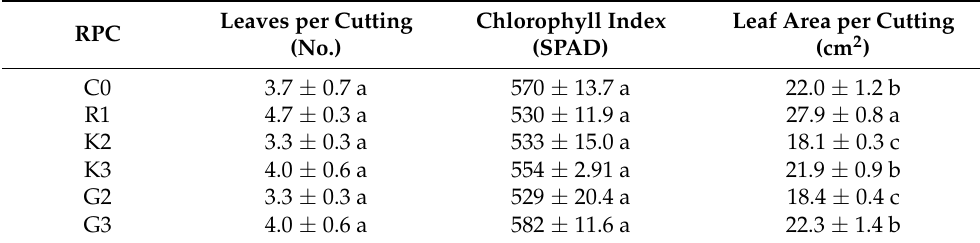
In columns, different letters indicate significant differences within parameters (S.N.K. test, p ≤ 0.05; mean ± SD, n = 3) C0: untreated control; R1: Rhizopon AA (1% IBA); K: Kelpak ® ; G: Goteo ® ; K2: 2 mL L − 1 ; K3: 3 mL L − 1